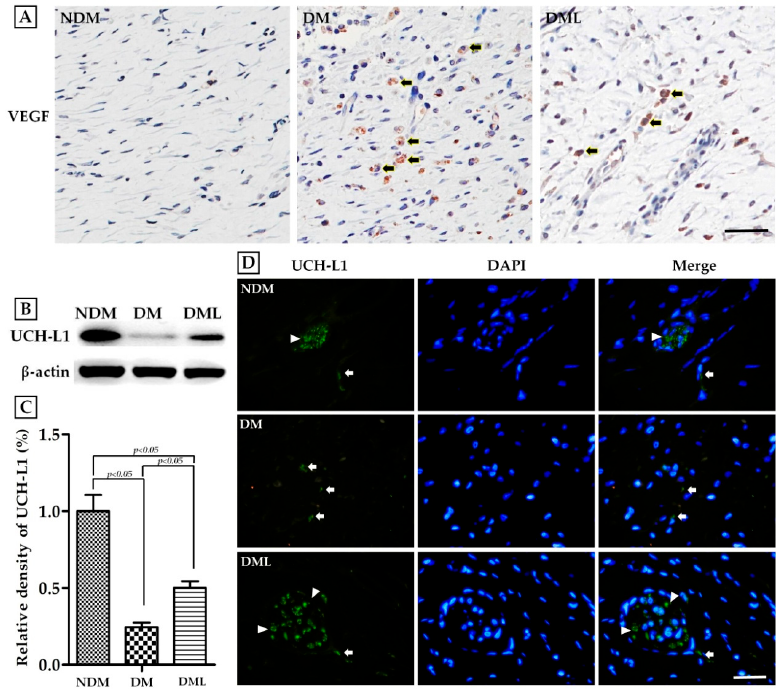
Figure 7. To determine the completeness of healing, tissue sections were obtained from the skin wound on day 14. ( A ) immunohistochemistry for VEGF. Brown areas indicate positive staining (arrowheads). ( B ) Tissues were homogenized in RIPA buffer and subjected to immunoblotting with anti-UCH-L1. ( C ) Quantitative results of UCH-L1 protein levels were adjusted to β -actin protein level. ( D ) Tissue sections were stained for UCH-L1 by immunofluorescence. White triangle denote the locations of UCH-L1-expressing nerve bundles. White arrowheads denote the locations of UCH-L1-expressing nerve fibers. Scale bars: 100 μ m.